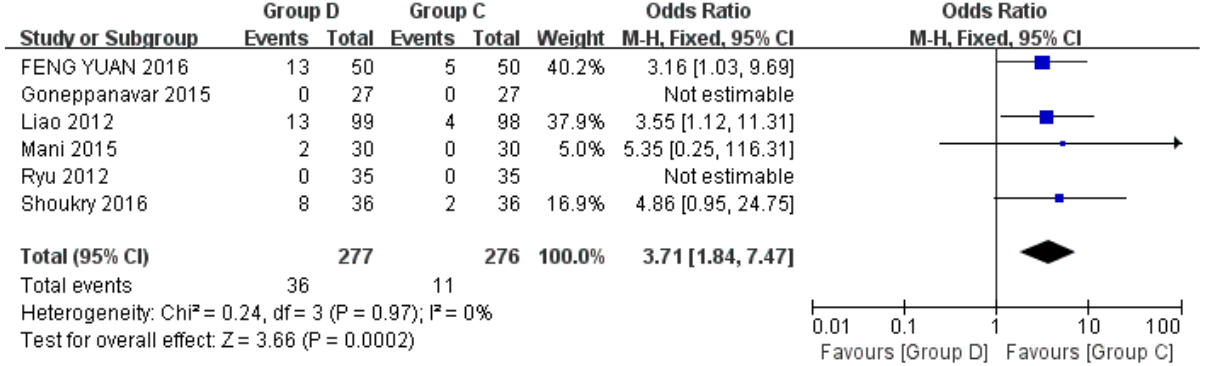
Figure 8. Forest plots comparing the effects of dexmedetomidine and control group on bradycardia [22–24,27–29].